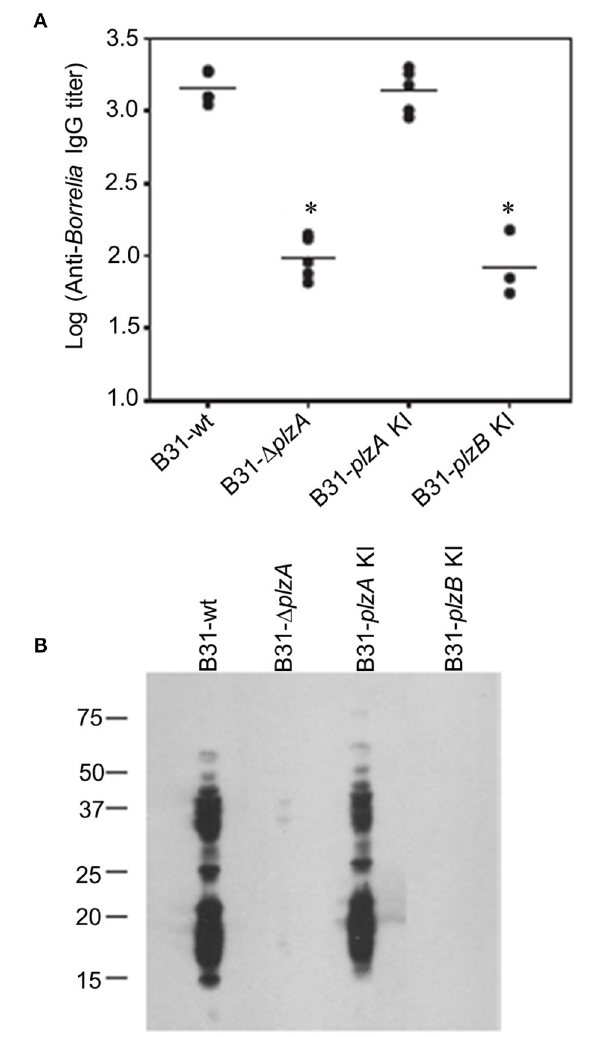
FIGURE 4 | PlzB does not restore infectivity to plzA gene deletion mutant delivered by needle inoculation. C3H-HeJ mice were inoculated by subcutaneous needle injection with 10 4 spirochetes of each strain investigated. Serum was collected from each mouse 4 weeks post-inoculation and anti -B. burgdorferi IgG titer was determined by ELISA (endpoint dilution) using whole cell lysate as the detecting antigen (A) . (B) Shows the results of immunoblot analyses. B. burgdorferi B31 served as the immobilized antigen. For the immunoblot analyses, serum samples from each experimental group were pooled. All methods were conducted as detailed in the text and statistical significance was assessed using the One-Way ANOVA. *Statistical significance was assessed relative to wild type ( p <